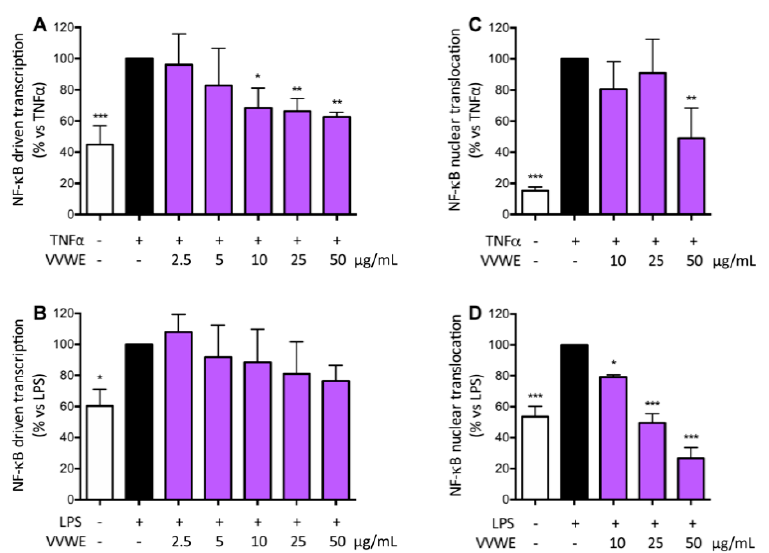
Figure 2. E ff ect of VVWE on the nuclear factor- κ B (NF- κ B)-driven transcription induced by TNF- α ( A ) or LPS ( B ). HaCaT cells were treated 6 h with TNF- α (10 ng / mL) or LPS (5 µ g / mL) and VVWE. NF- κ B nuclear translocation was evaluated in HaCaT cells treated for 1 h with TNF- α ( C ) or LPS ( D ) and VVWE (10–50 µ g / mL). The graphs show the means ± SD of at least three experiments performed in triplicate and duplicate, for transcription and translocation respectively. Statistical analysis: one-way ANOVA, followed by Bonferroni’s post hoc test. * p < 0.05, ** p < 0.01, *** p < 0.001 vs. TNF- α or LPS alone. Here, 20 µ M EGCG were used as the reference inhibitor of TNF- α or LPS-induced NF- κ B-driven transcription (59.9 and 29.9% inhibition, respectively) and NF- κ B nuclear translocation (62.4% and 53.2% inhibition, respectively).